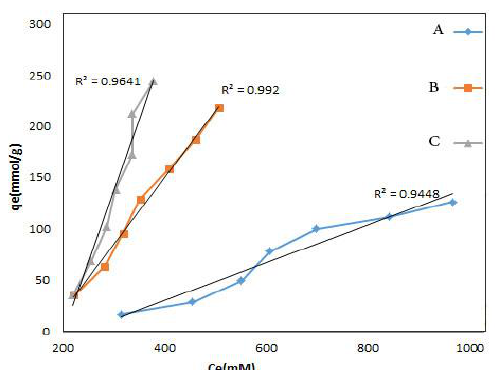
O nanosorbent, 3 4